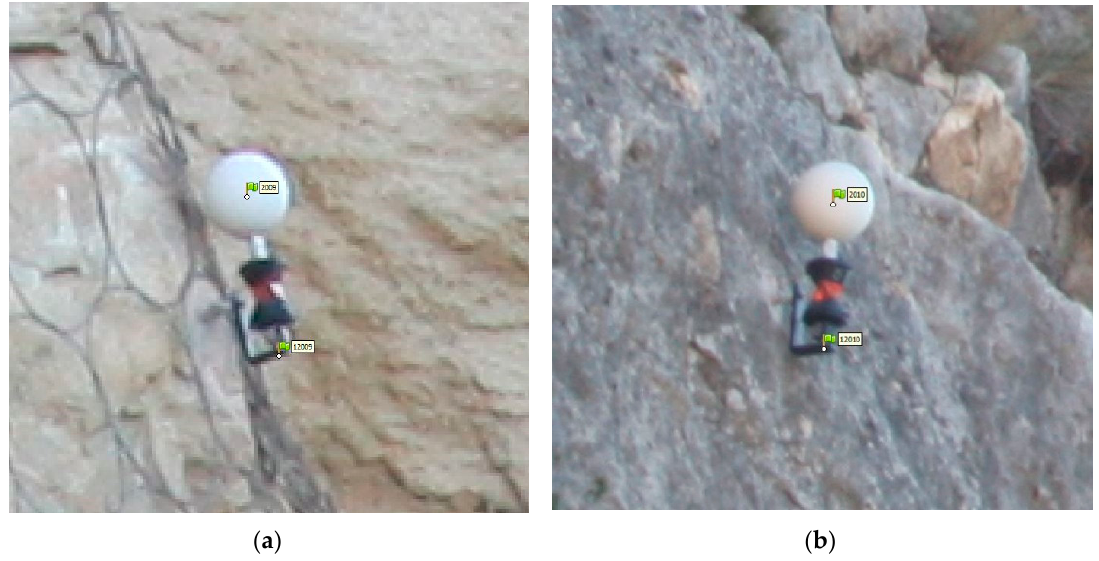
Figure 3. Example of check point (center of the 360° prism) on site: ( a ) number 1009; ( b ) number 1010.